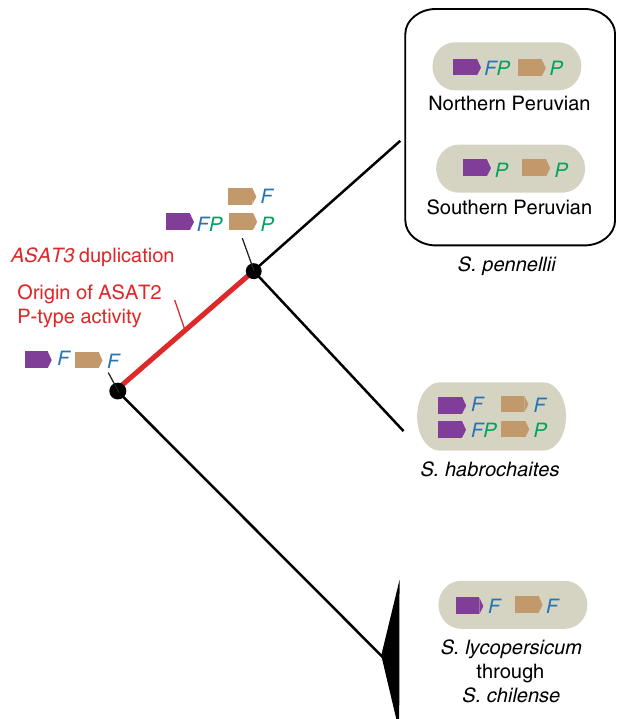
Fig. 7 Summary of results suggesting that P-type ASAT2 and ASAT3 enzyme evolution occurred after the last common ancestor of the tomato clade of Solanum. Ancestral ASAT2 and ASAT3 genotypes were inferred based on the ASAT2 (Supplementary Fig. 11) and ASAT3 (Supplementary Fig. 12) gene phylogenies. It suggests that the ASAT3 duplication event and the origin of ASAT2 P-type activity occurred before the speciation of S. habrochaites and S. pennellii (the red-colored branch) and away from the lineage containing the cultivated tomato S. lycopersicum and its